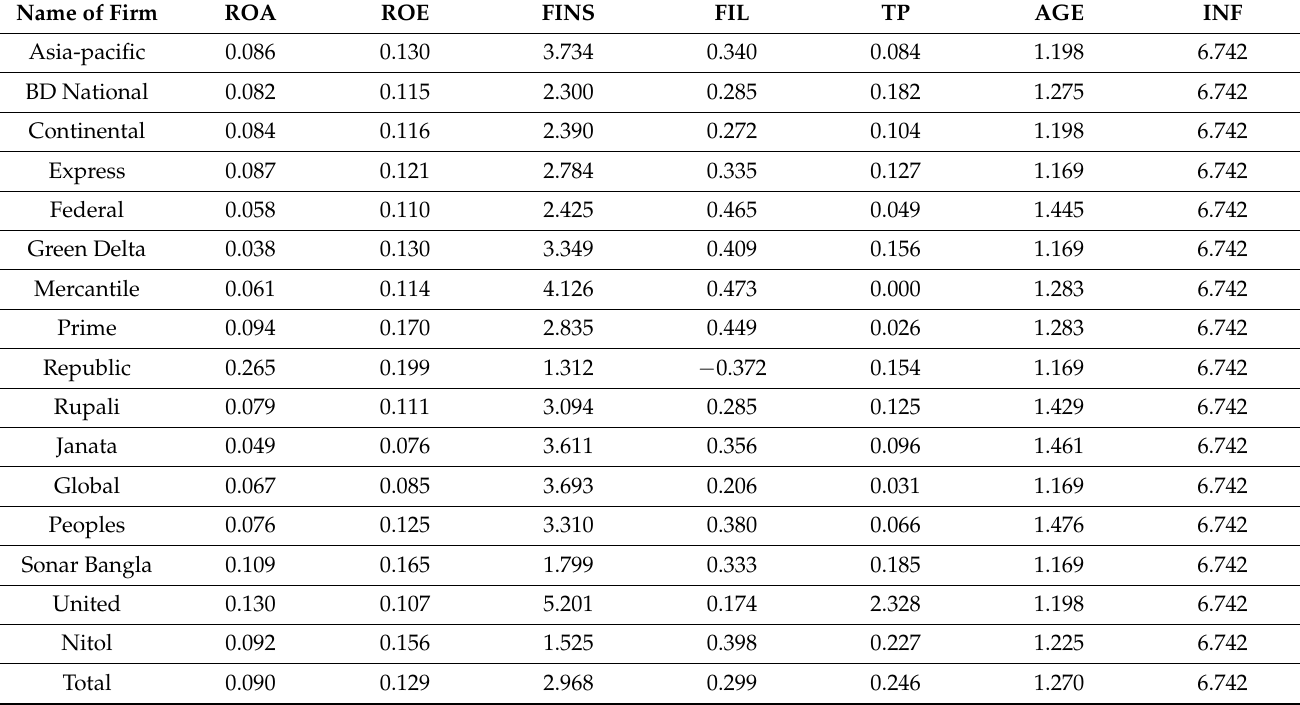
Table 4. Non-life insurance company-wise mean value of all